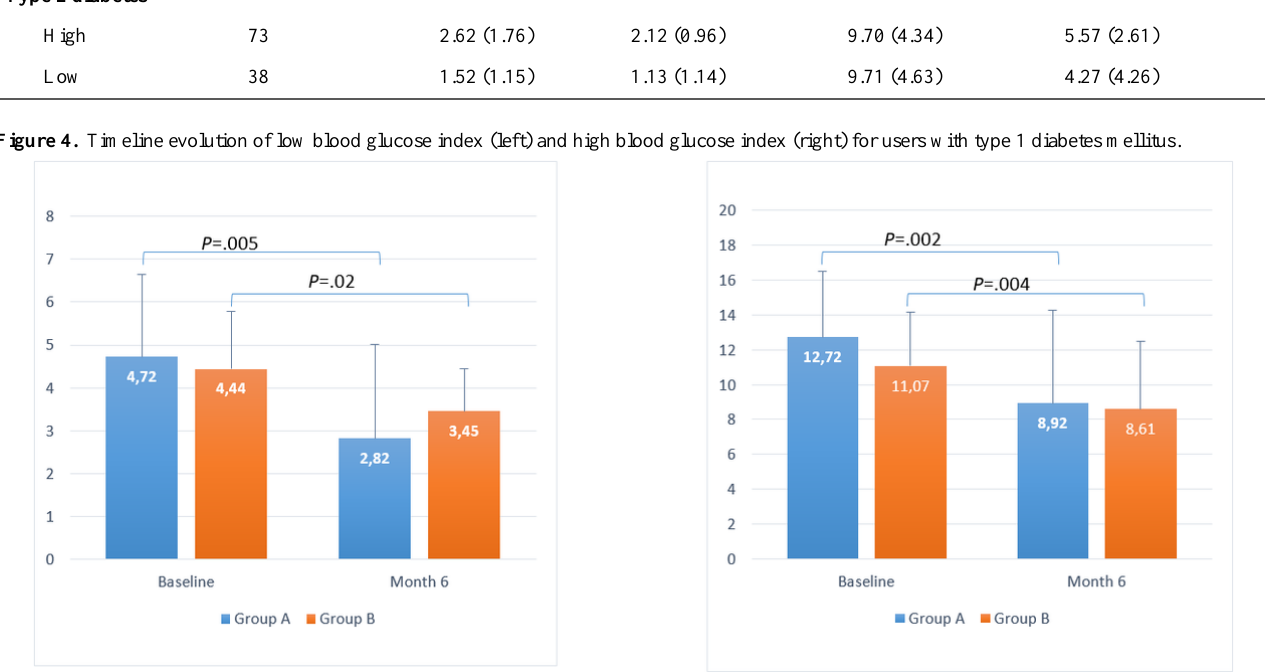
High blood glucose indexLow blood glucose indexNType and engagement